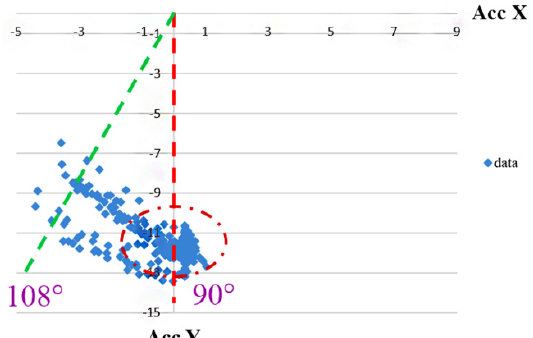
Figure 8. Detected angles after removing the gravity at different swing speeds. Note that Acc X (unit: g) and Acc Y (unit: g) represent the measured acceleration from x - and y -direction of the accelerometer, respectively.